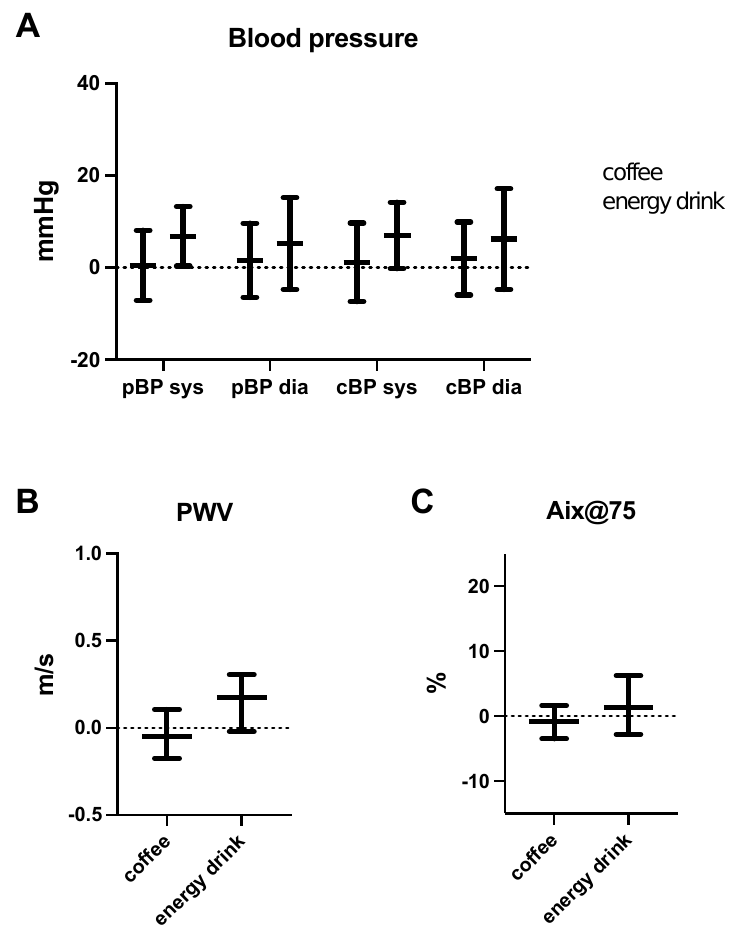
Figure 1. Hemodynamic parameters after caffeine consumption. Effect of energy drink and coffee consumption on systolic (sys) and diastolic (dia) peripheral (pBP) as well as central blood pressure (cBP) ( A ), pulse wave velocity (PWV) ( B ) and augmentation index (Aix) ( C ). Dots and triangles represent individual values.